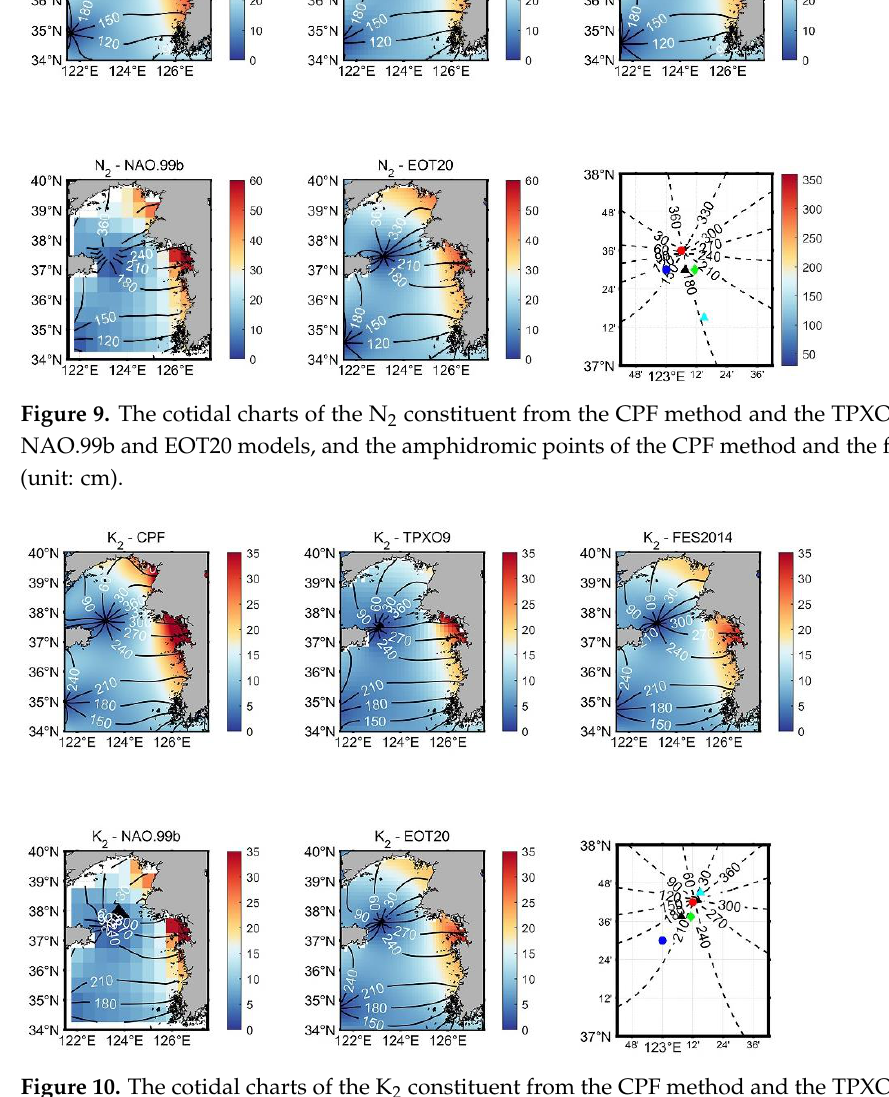
Figure 10. The cotidal charts of the K 2 constituent from the CPF method and the TPXO9, FES2014, NAO.99b and EOT20 models, and the amphidromic points of the CPF method and the four models (unit: cm).